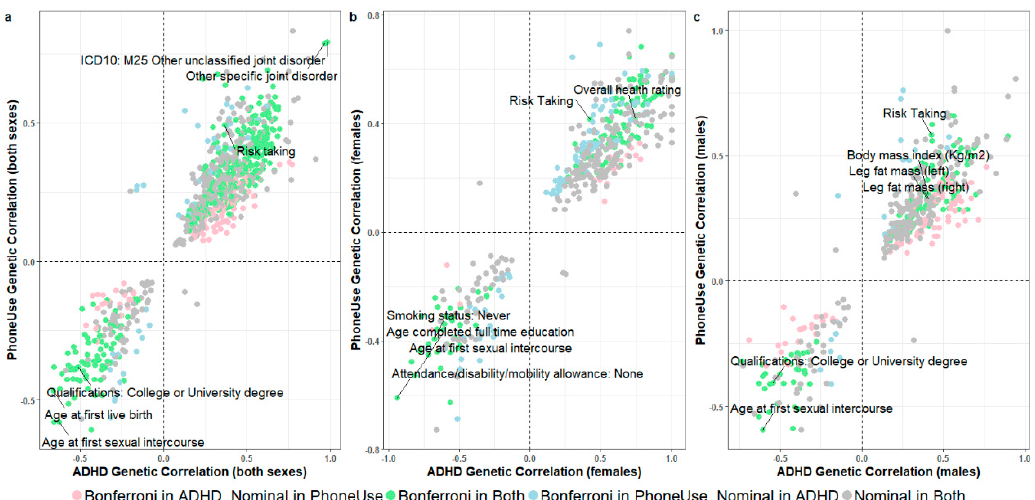
Figure 4. Scatterplots of genetic correlation results for attention deficit hyperactivity disorder (ADHD) and PhoneUse , for both sexes combined ( a ; N = 841 traits), females only ( b ; N = 478 traits), and males only ( c ; N = 435 traits). Labeled traits are among the top ten most significant genetic correlations in ADHD and PhoneUse (UKB Field ID 1120 “ weekly usage of mobile phone in last three months ”). Detailed genetic correlation results surviving multiple testing correction are provided in Tables S21–S23.